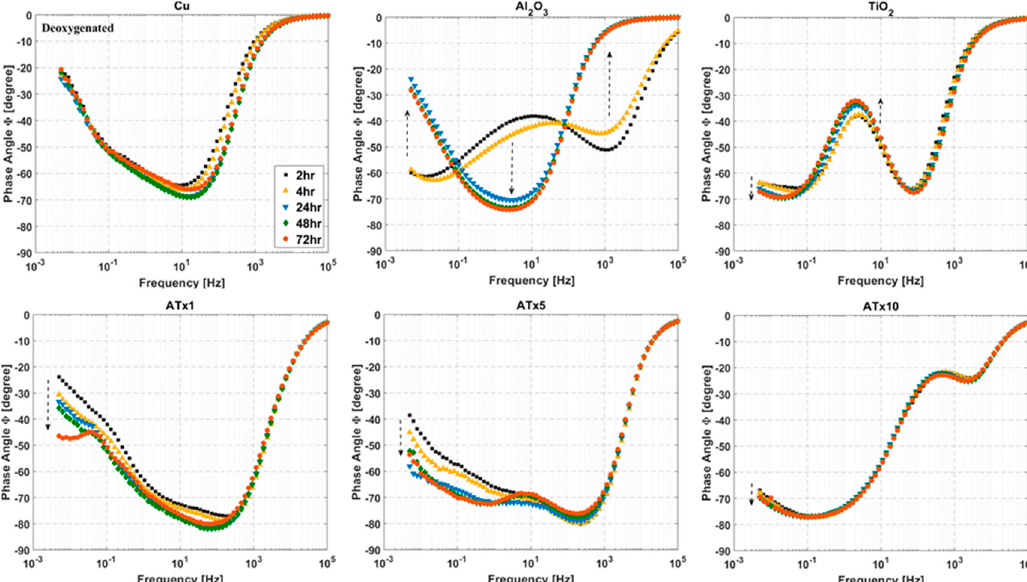
Figure 8. Impedance phase angle versus frequency at selected time intervals over 72-h immersion in deoxygenated 0.1 M NaCl. Frequency range is 100 kHz to 5 mHz and sample type is given above each plot. Dashed arrows indicate increasing immersion time. Refer to Table 1 for sample descriptions.